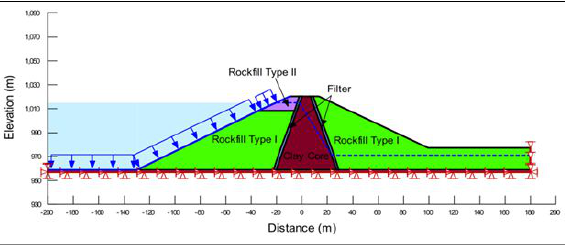
Fig. 2. Model profile of the rockfill